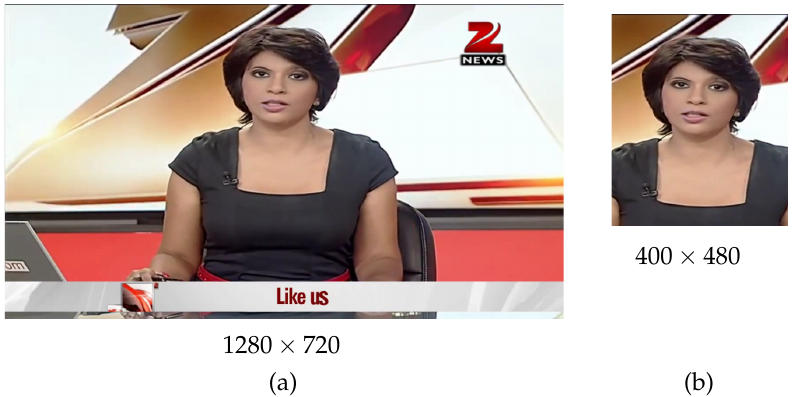
Figure 6. A randomly selected image from the Face2Face part of FaceForensics ++ . ( a ) The fullsize image of size 1280 × 720. ( b ) The crop image of size 400 × 480 cropped from the full size